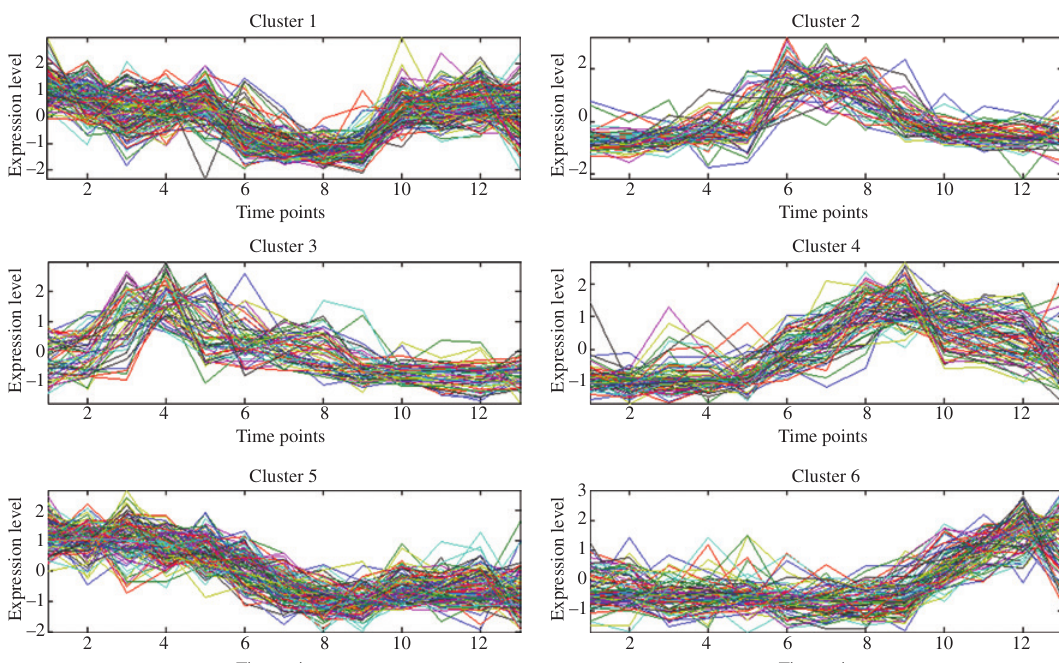
Figure 4: Cluster Profile Plots of Human Fibroblast Serum Data Clustered Using